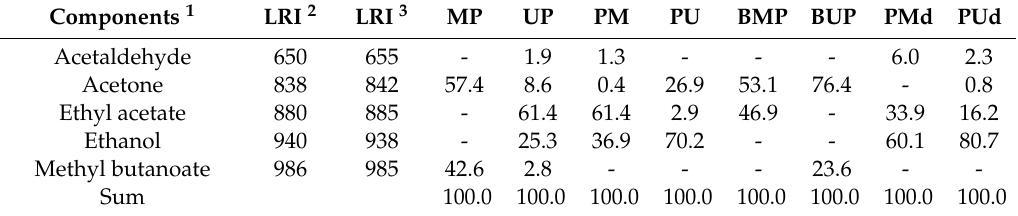
Table 2. HS-GC peak area (%) of fresh and defrosted (d) strawberries to which was applied a pasteurization process before or after homogenization or after blanching and